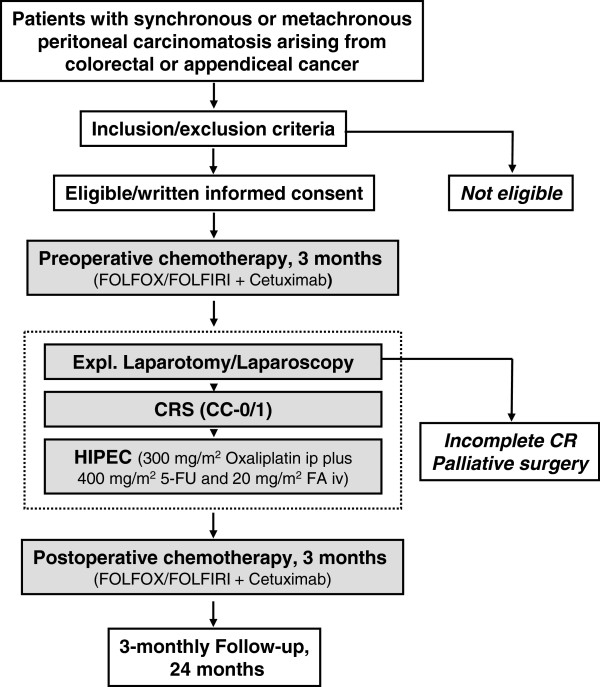
Flowchart of the COMBATAC study.